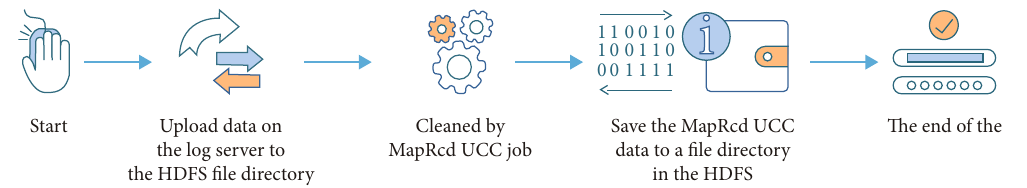
Figure 3: Flow chart of complete repeated data processing.